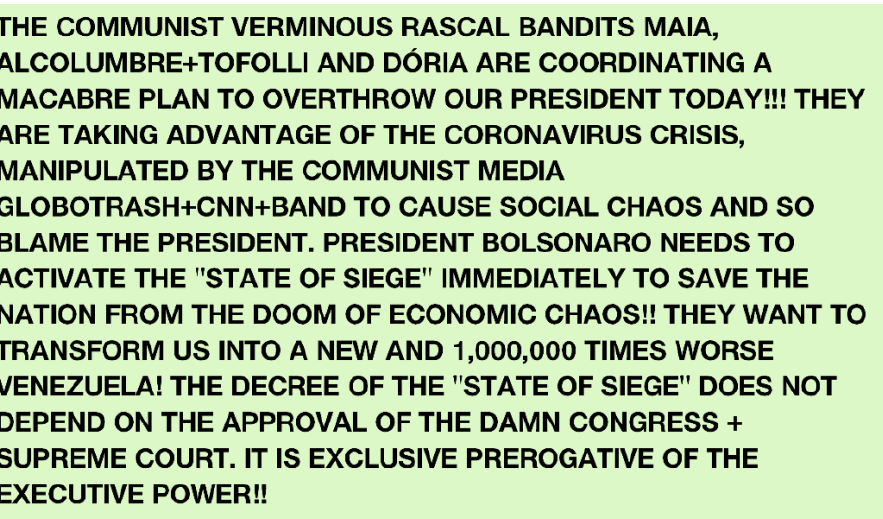
Figure 6. Conspiracy theory about politics in Brazil.